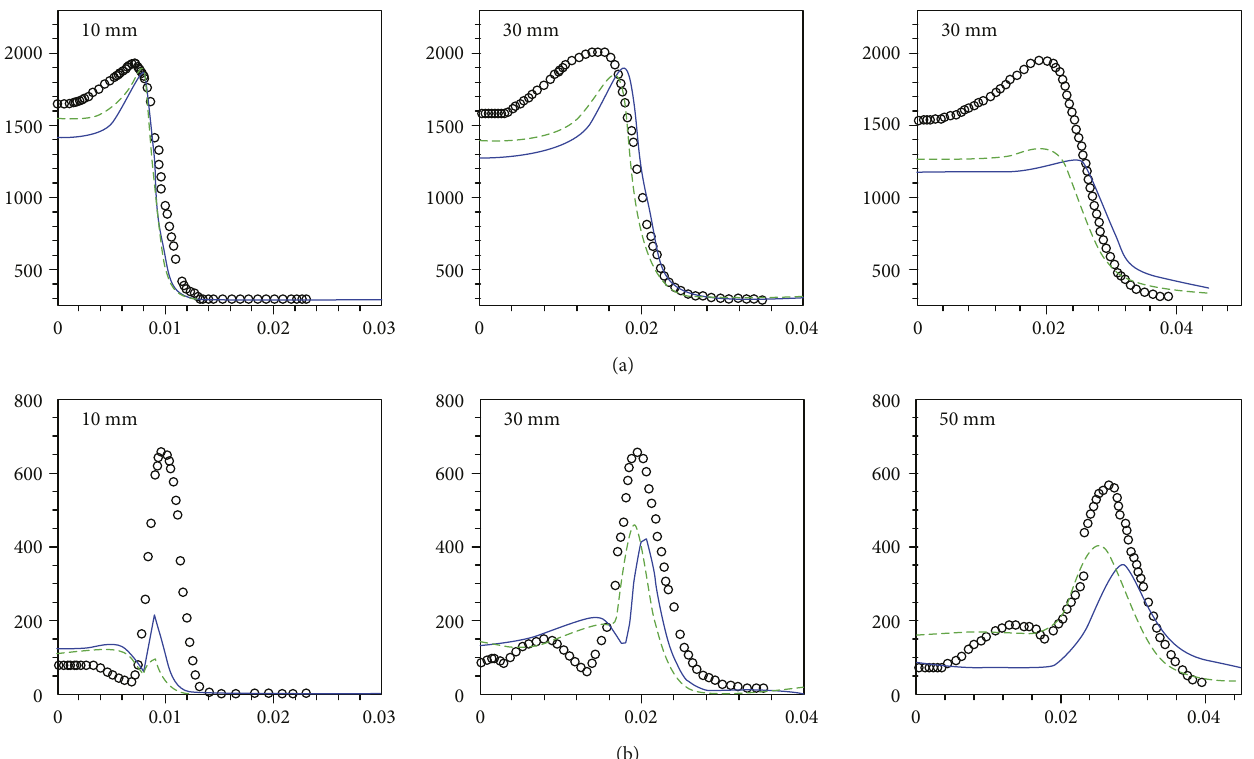
Figure 9: Comparison of mean (a) and rms (b) temperature at Δ X = 10mm , 30 mm, and 50mm (circles, experimental results; dash line, Mech I simulation; solid line, Mech II